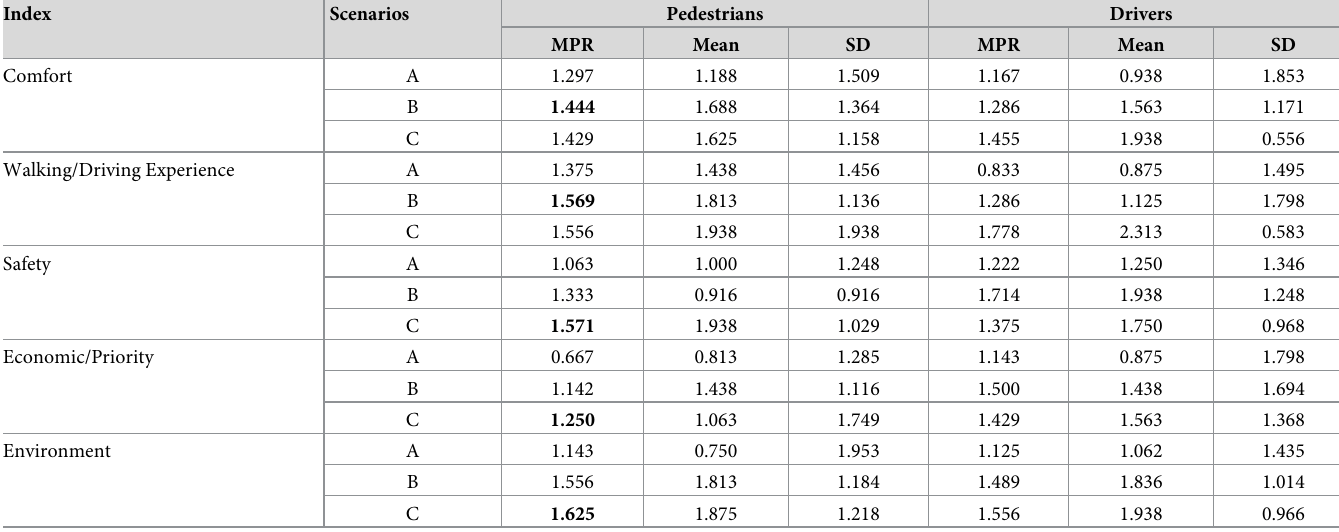
Table 4. Median Perception Rating